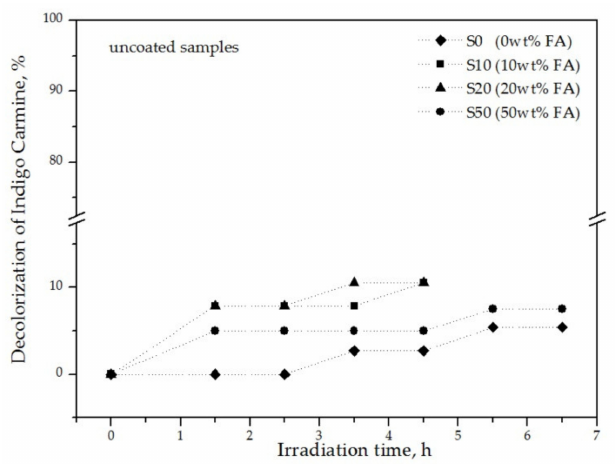
Figure 7. Decolorization ability of uncoated samples as a function of irradiation time.